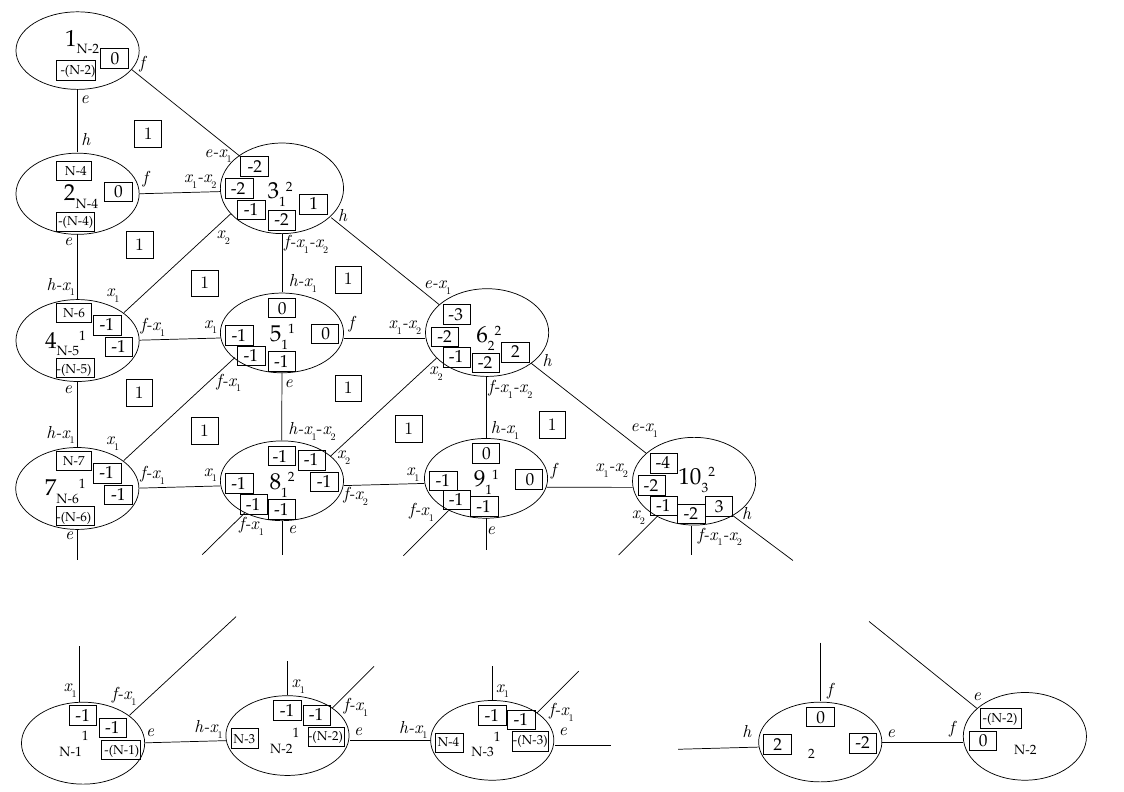
Figure 12 . The surface component for B N for general N . The last row is always retained for any N (i.e. to obtain the diagram for B 6 , remove fourth row).